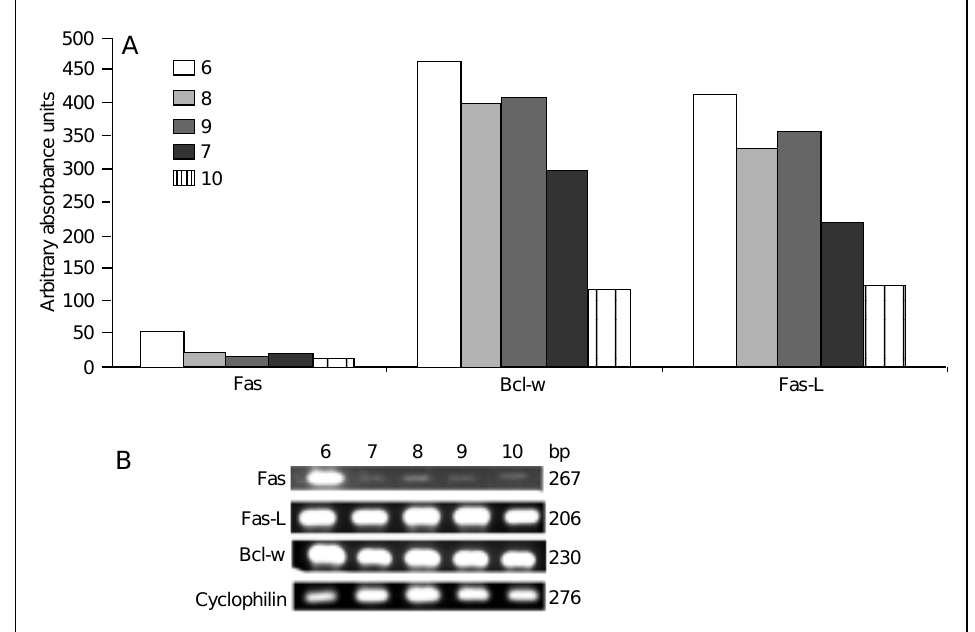
Figure 3. Individual levels of ex- pression of Fas, Fas-ligand (Fas- L) and Bcl-w in NOD mice treated with potassium iodide (20 mg/animal) after receiving methimazole in drinking water from the 4th to the 10th week of life. A , Semiquantitative mea- surement for each animal (num- bers 6-10), showing different patterns of response for Fas-L and Bcl-w. B , Representative 1.5% agarose gel eletrophore-